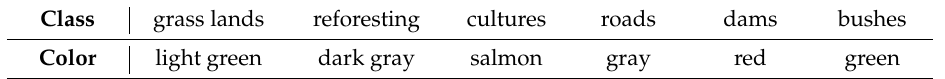
Table 1. Colors corresponding to the six classes contained in the CBERS-2B and Landsat-5 images.